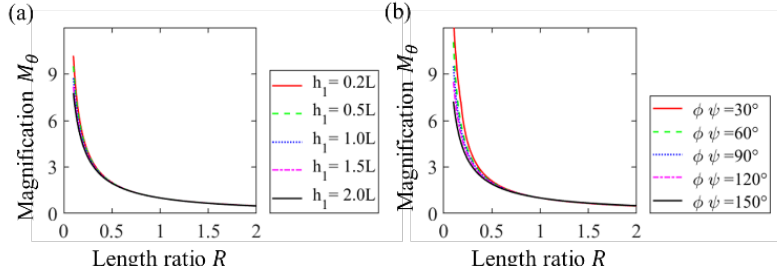
Figure 9. Angle magnification M θ as a function of linkage length ratio R = h 1 / h 2 in a single four-bar linkage finger structure: ( a ) with various h 1 ranging from 0.2 to 2.0 L with fixed initial ϕ and ψ angles 90 ◦ , and ( b ) with various initial angle ϕ and ψ ranging from 30 ◦ to 150 ◦ when h 1 = 0.5 L .